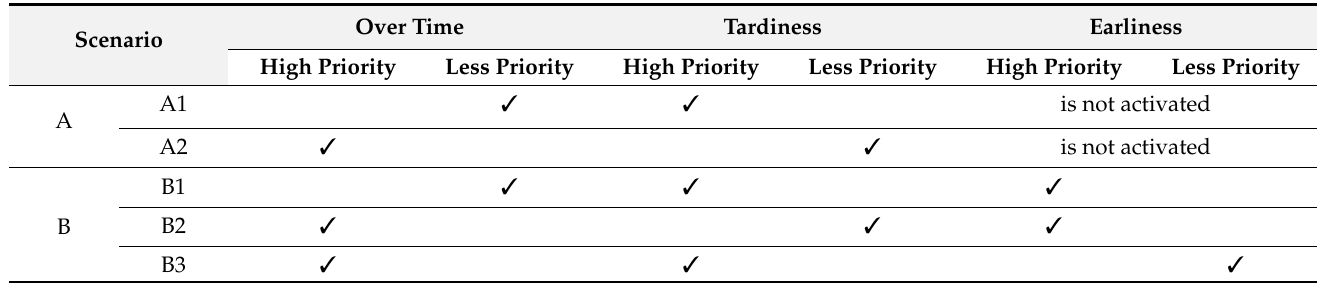
Table 5. Scenarios for case study.